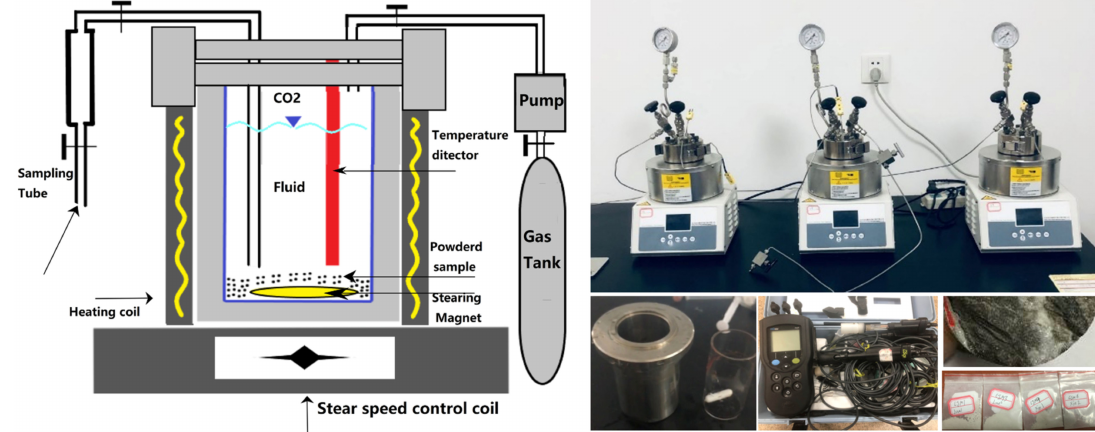
Figure 3. A schematic representation of the work sequence followed in this study.